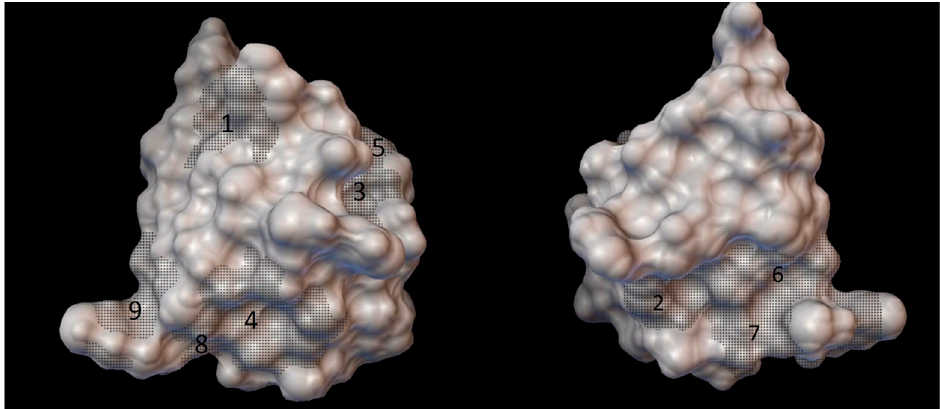
Figure 3. The molecular surface of the insulin molecule from the front and back, marked with small black dots are the 9 binding sites obtained from the CB-Dock, numbered in order of fervency of the parameters which appeared in the results (Marked with 1 the most fervently appeared binding site, and with 9 the most rarely appeared binding site).